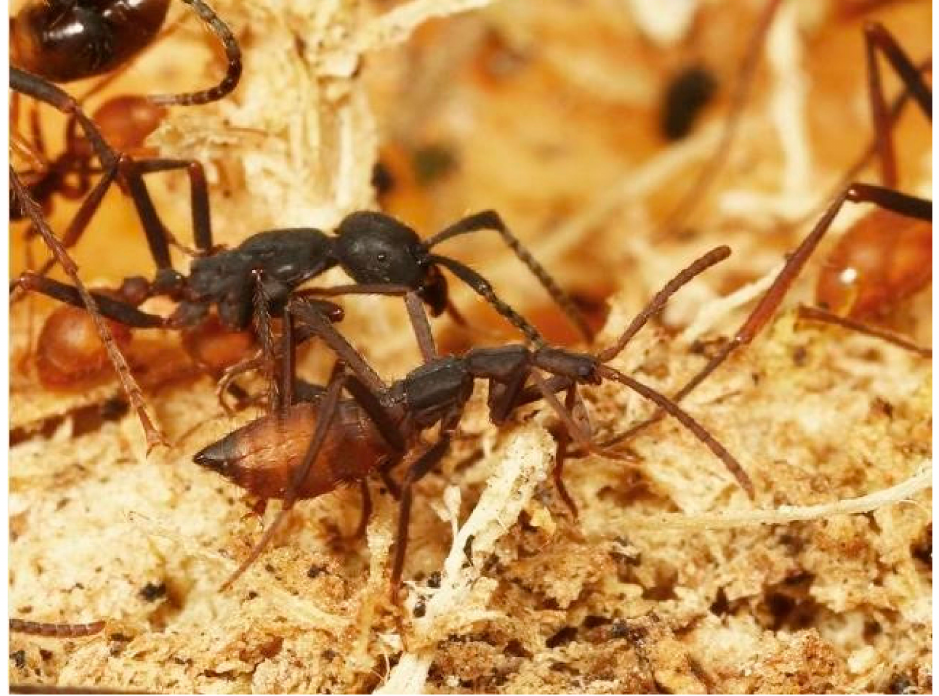
Figure 3. The rove beetle Ecitophya simulans (family Staphylinidae) moderately mimics of Eciton burchellii media workers and is considered a hunting guest. Photo of Ecitophya simulans next to an Eciton burchellii foreli media worker (Taku